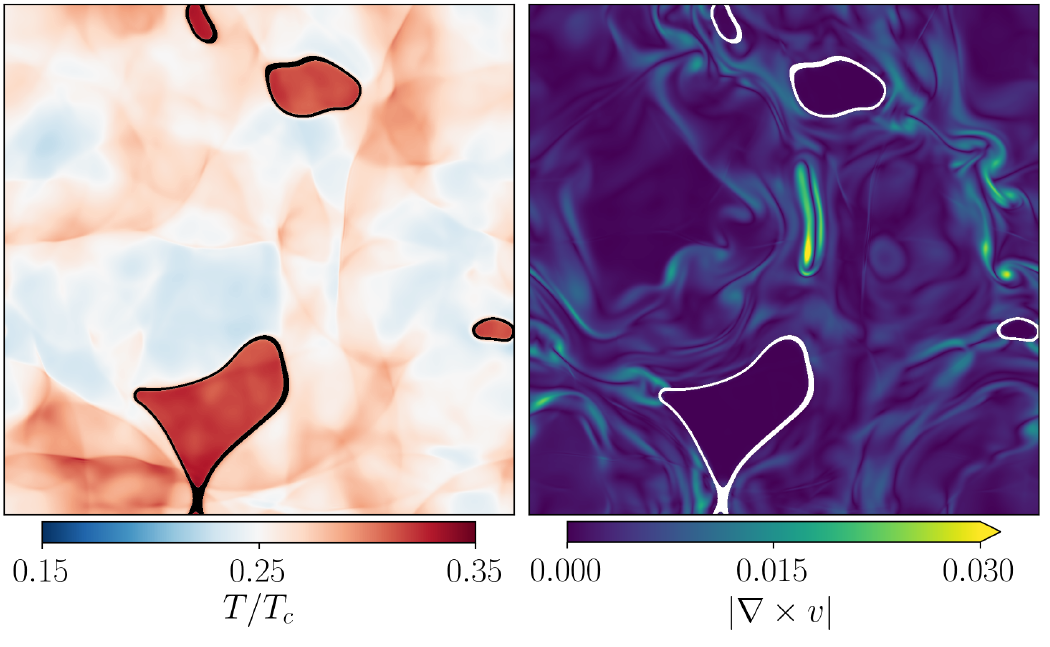
Figure 21: Slice through a numerical simulation of the field-fluid system, show- ing temperature (left) and vorticity (right) following a strong phase transition, with α = 0.5 and v = 0.44 [ 97 ] . The temperature is highest inside shrinking droplets n w of the symmetric phase. The vorticity (shown in units of the critical temperature T is highest around the sites of bubble collisions. (Figure courtesy D.